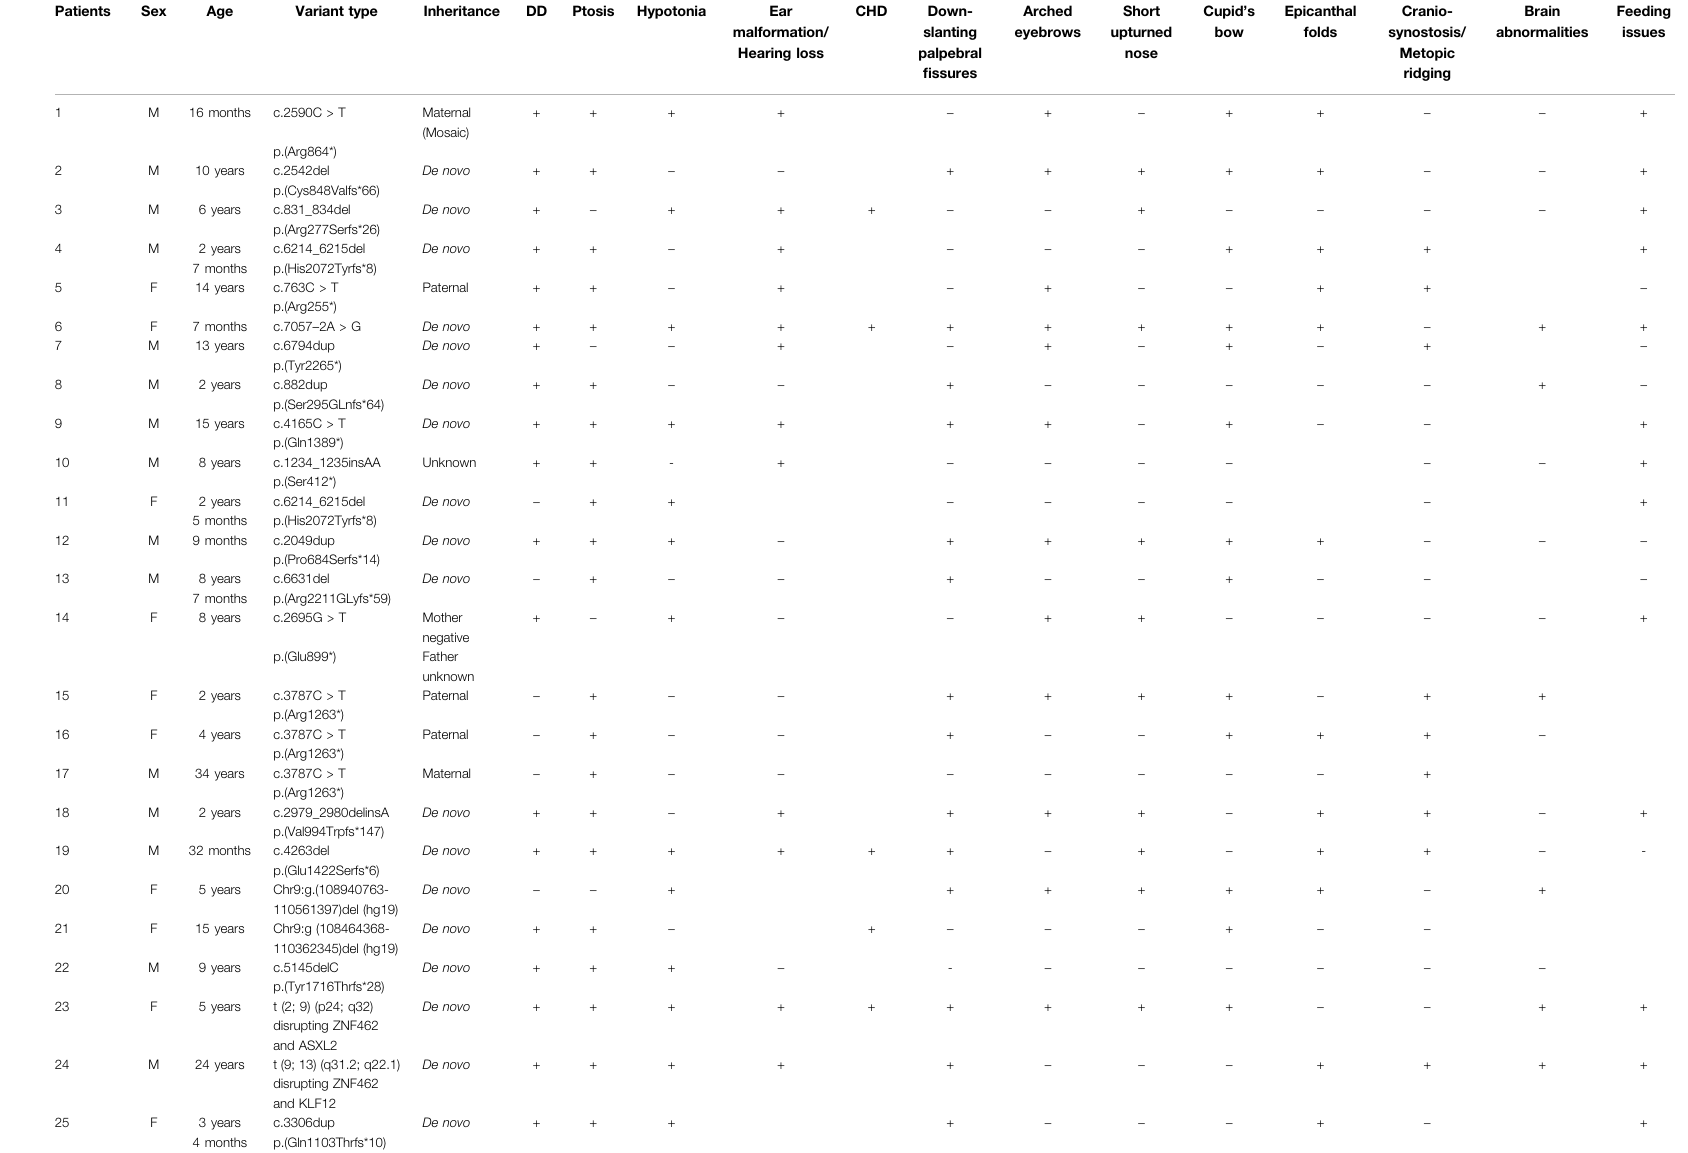
TABLE 1 | Clinical phenotypes of 29 patients and the family patients of this study caused by ZNF462 gene mutation.